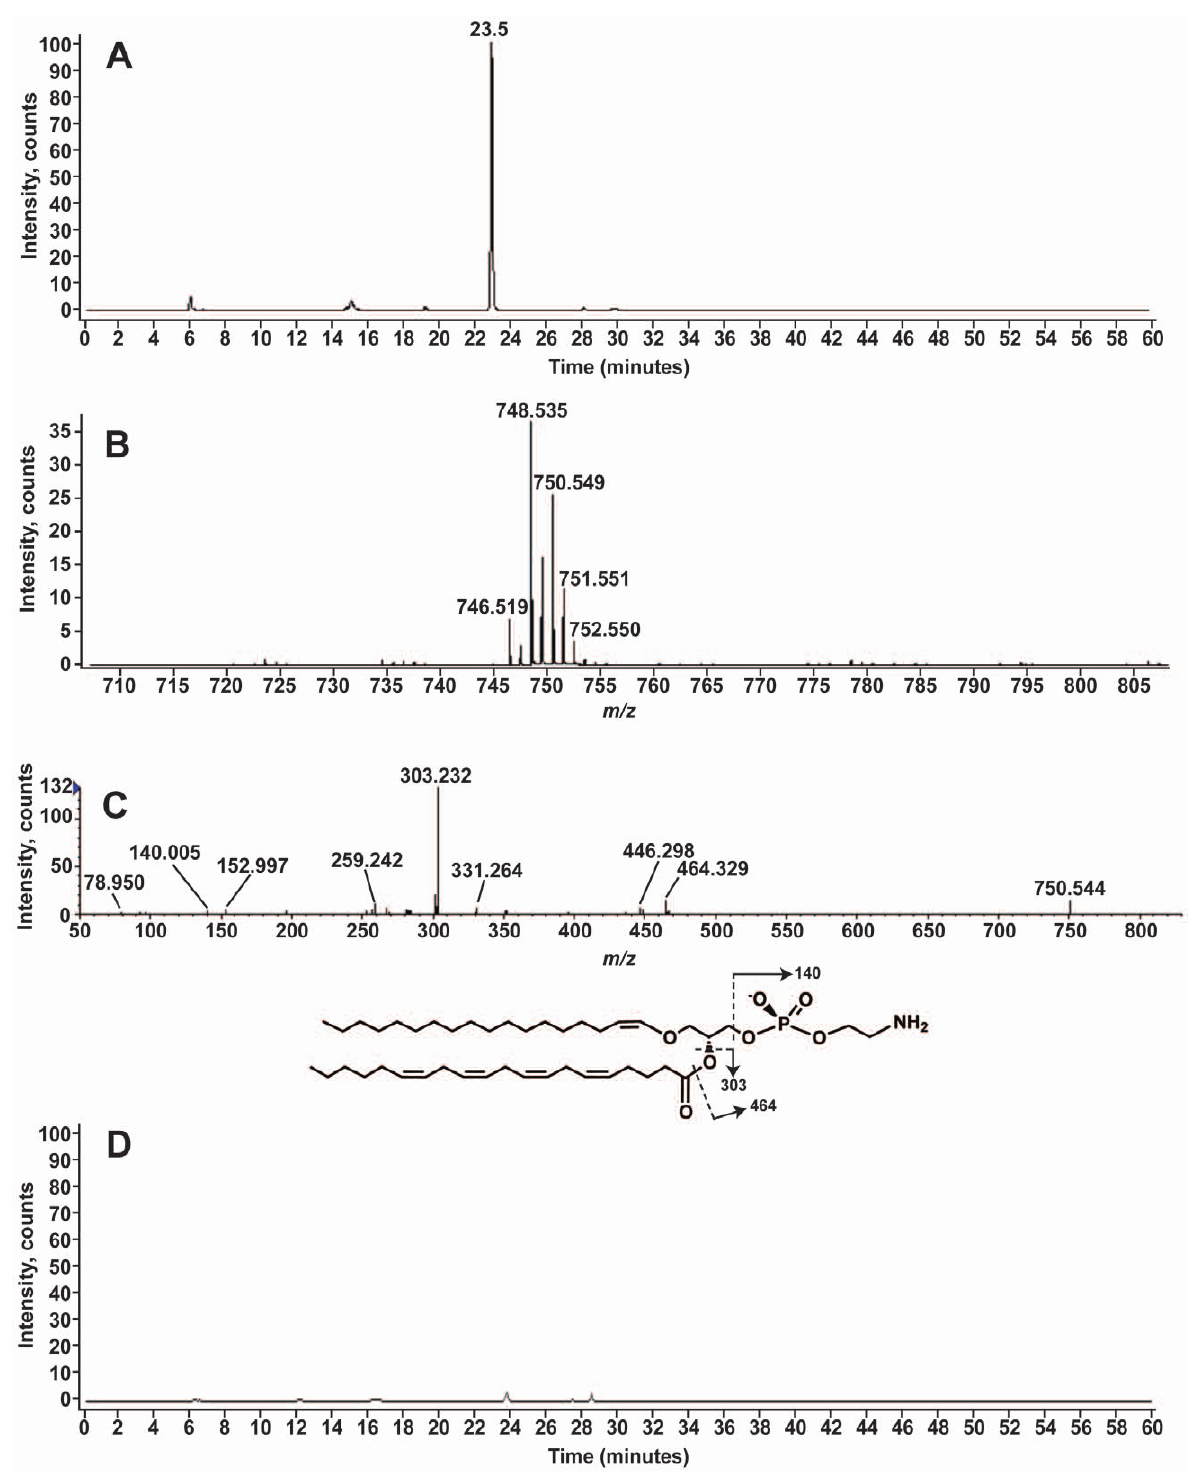
Figure 5. Plasmenyl phosphatidylethanolamines identified in A.pallida . Panel A shows the EIC of m/z 750.5, the mass corresponding to 38:6 alkylPE. The negative-ion mass spectrum from m/z 700 to 810 for the lipids eluting between 22.8 and 23.5 minutes is shown in Panel B. Panel C shows the MS/MS analysis of 750.5. Panel D shows the EIC for m/z 750.5 following acid hydrolysis of the total lipid extract. The predicted structure is shown with selected product ions shown. The alkyl PE is shown with the double bond at the 1 position of the ether-linked chain as is known to occur for plasmalogen PE [25]. The product ion at m/z 331.264 suggests that a portion of the lipids at m/z 750.5 has a 22:4 ester linked acyl chain and a 16- carbon ether linked chain.